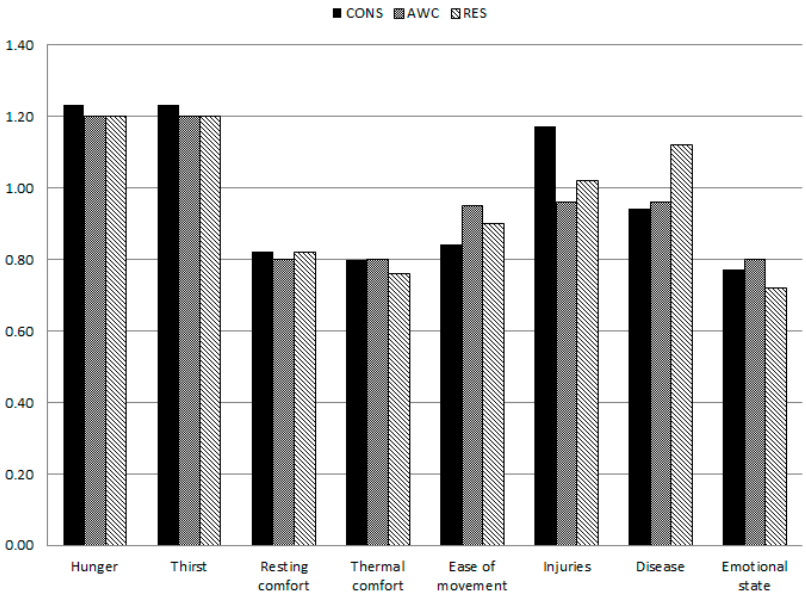
Figure 1. Median expert weights for welfare criteria given by three different Danish swine expert groups, production advisors/consultants (CONS), animal welfare control officers (AWC) and animal welfare researchers (RES) in two online surveys (2012, 2016).